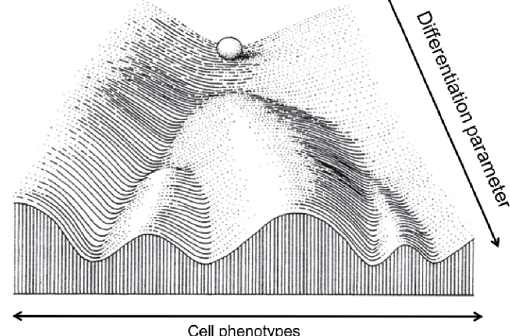
Figure 1: Sketch of communication between cell and its microenvironment. HaralamposHatzikirou isthecorrespondingauthor.